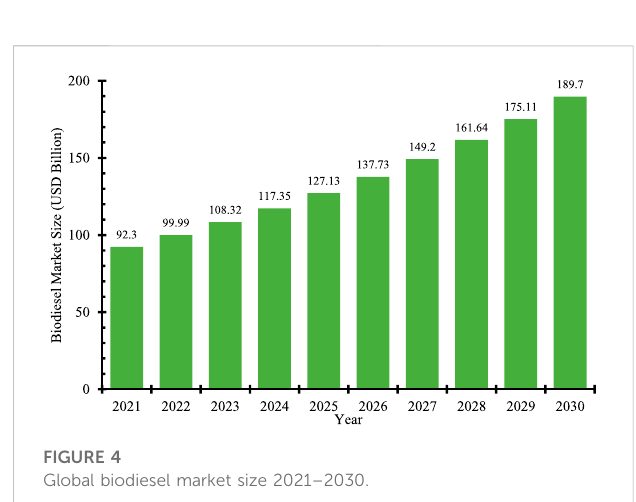
FIGURE 4 Global biodiesel market size 2021 –